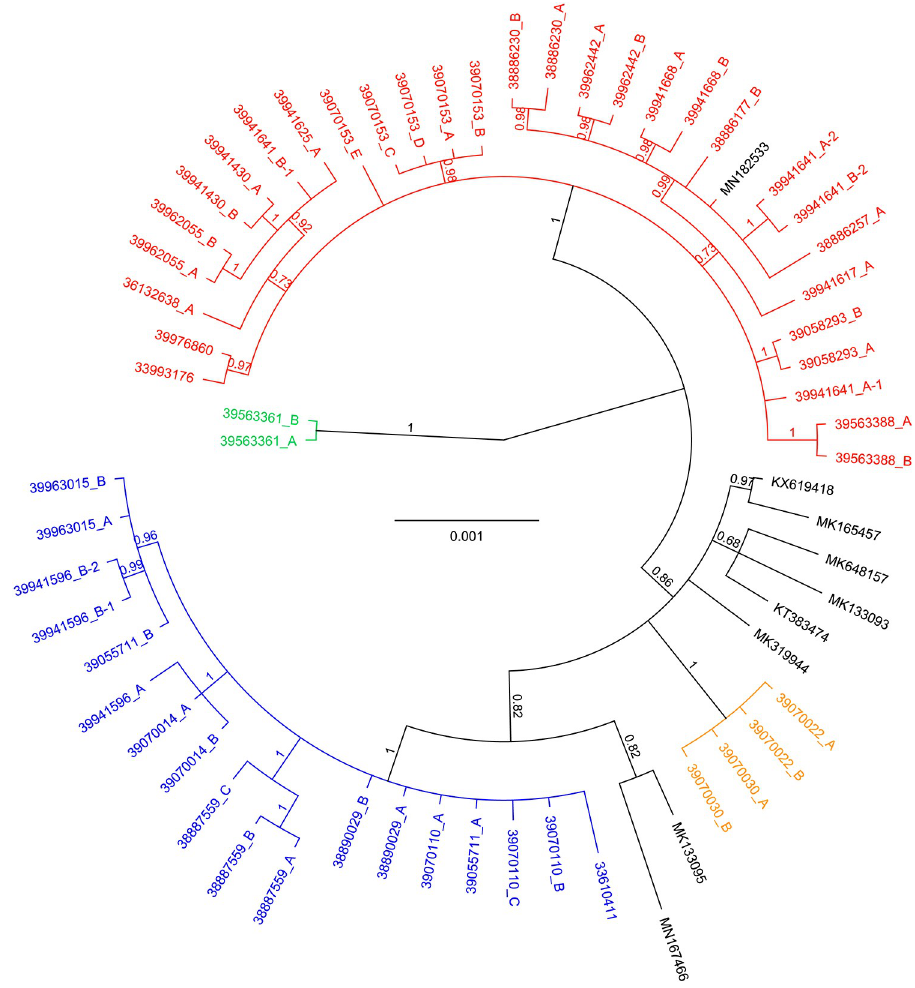
Fig 2. Bayesian inference of phylogeny based on a 6,404 nt alignment of 63 complete ToBRFV genomes. Viral strains from the Dutch outbreak are found in three separate clusters which have been colored red, blue and green. Four ToBRFV genome sequences generated from material intercepted during an import inspection from Egypt form a separate cluster (orange). Bayesian posterior probabilities (PP) are displayed at the branch nodes. The scale bar indicates the number of substitutions per